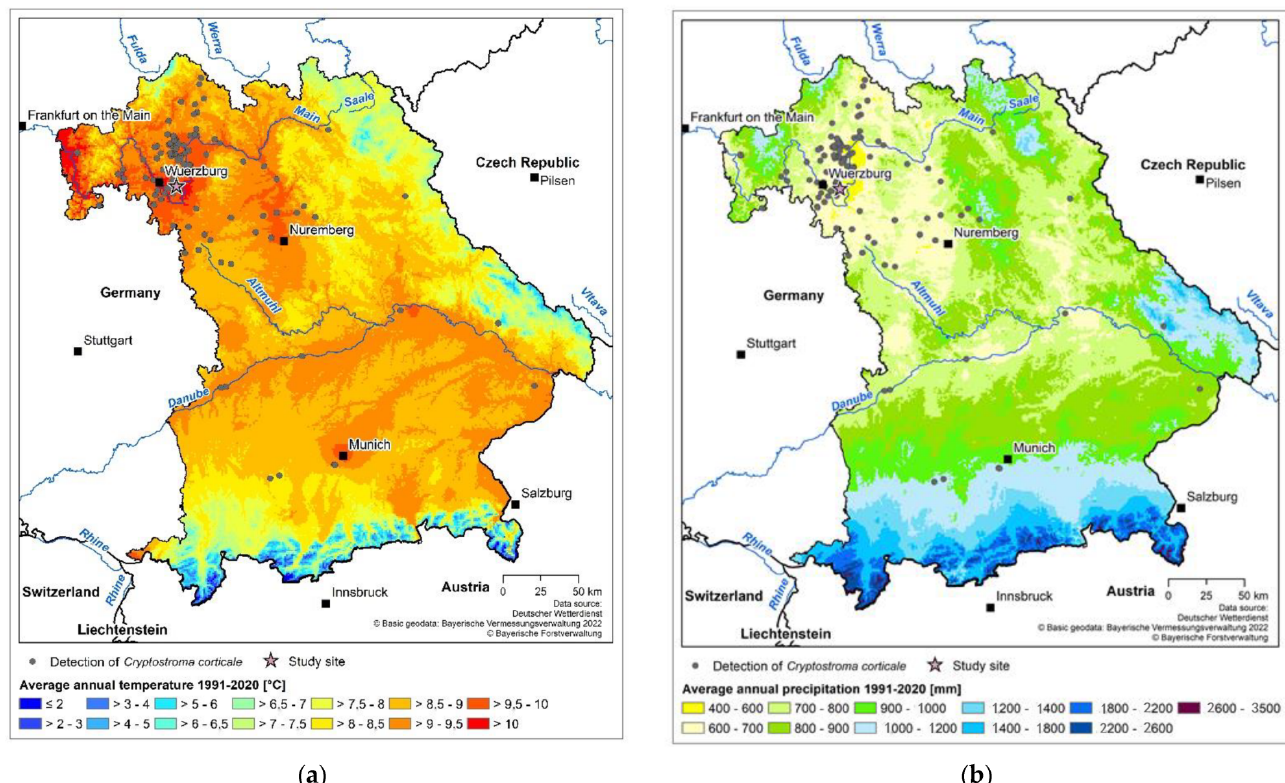
Figure 1. Distribution of sooty bark disease caused by Cryptostroma corticale in the south-east of Germany (Bavaria) from the first detection in summer 2018 to summer 2022, with a hotspot in Lower Franconia around Wuerzburg; grey dots symbolize the points of detection of C. corticale , and the grey star south-east of Wuerzburg symbolizes the study site: ( a ) average annual temperature 1991–2020 ◦ C; ( b ) average annual precipitation 1991–2020